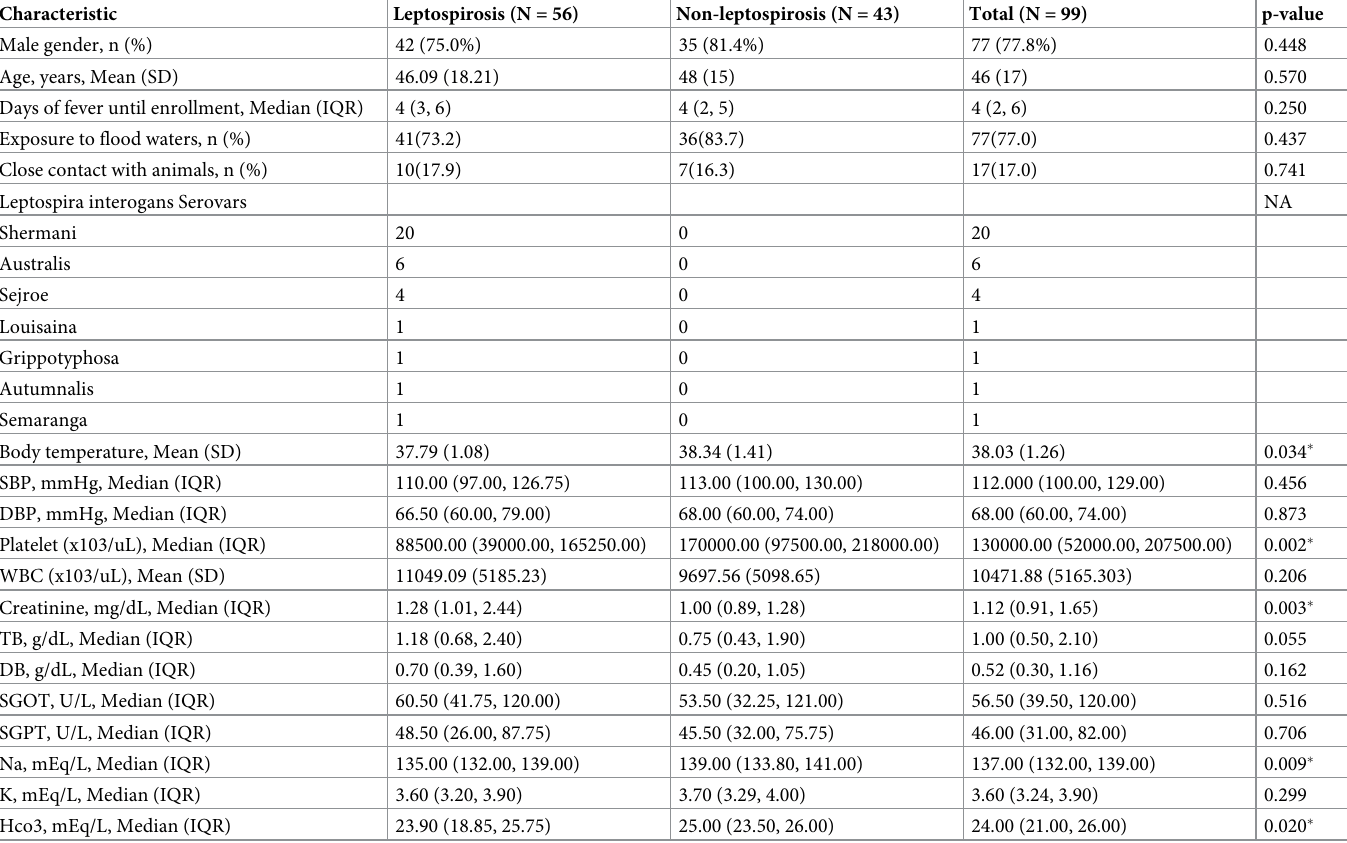
sensitivity ranging from 1.8% to 75% and specificity ranging from 52.3% to 97.7%. The RDT2 and RDT1 had high sensitivity of 75.0% and 60.7%, respectively, while RDT4, RDT5 and RDT3 had low sensitivity of 33.9%, 3.6%, and 1.8%, respectively. On the contrary, RDT5, Table 1. Patients’ clinical and laboratory characteristics of confirmed-leptospirosis and non-leptospirosis